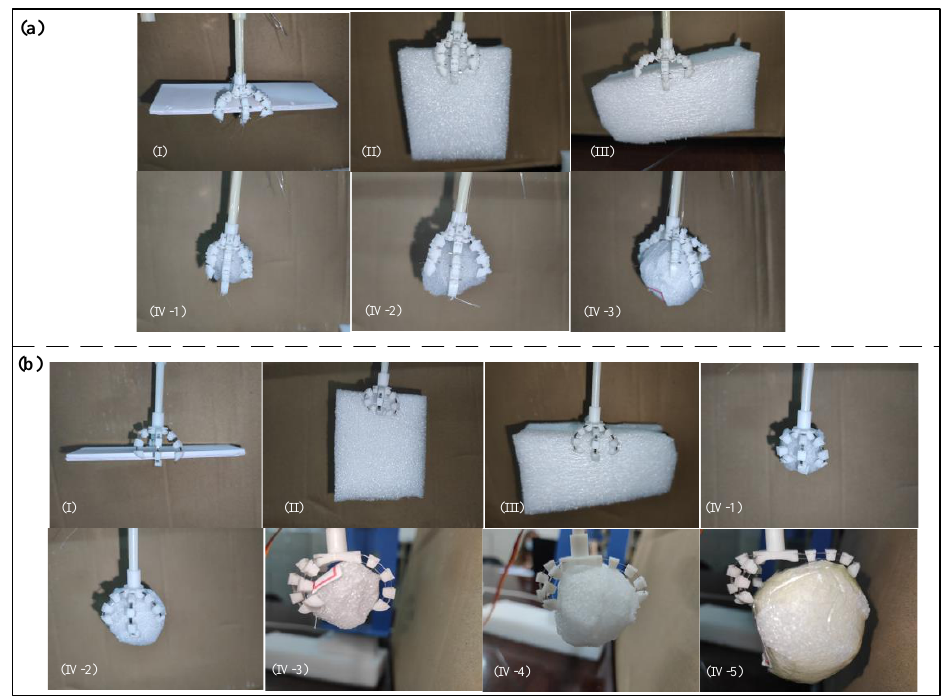
Figure 10. Adaptive performance experiments of two perching grasping mechanisms. ( a ) Articulated. ( b ) Elastic reset type. (I) Rectangular cardboard (thin and smooth), (II) rectangular foam object (thicker), (III) irregular foam object (thicker), (IV) near spherical foam object (IV-1) – (IV-5) (diameters approximately 18 mm, 26 mm, 35 mm, 45 mm, 55 mm in that order).